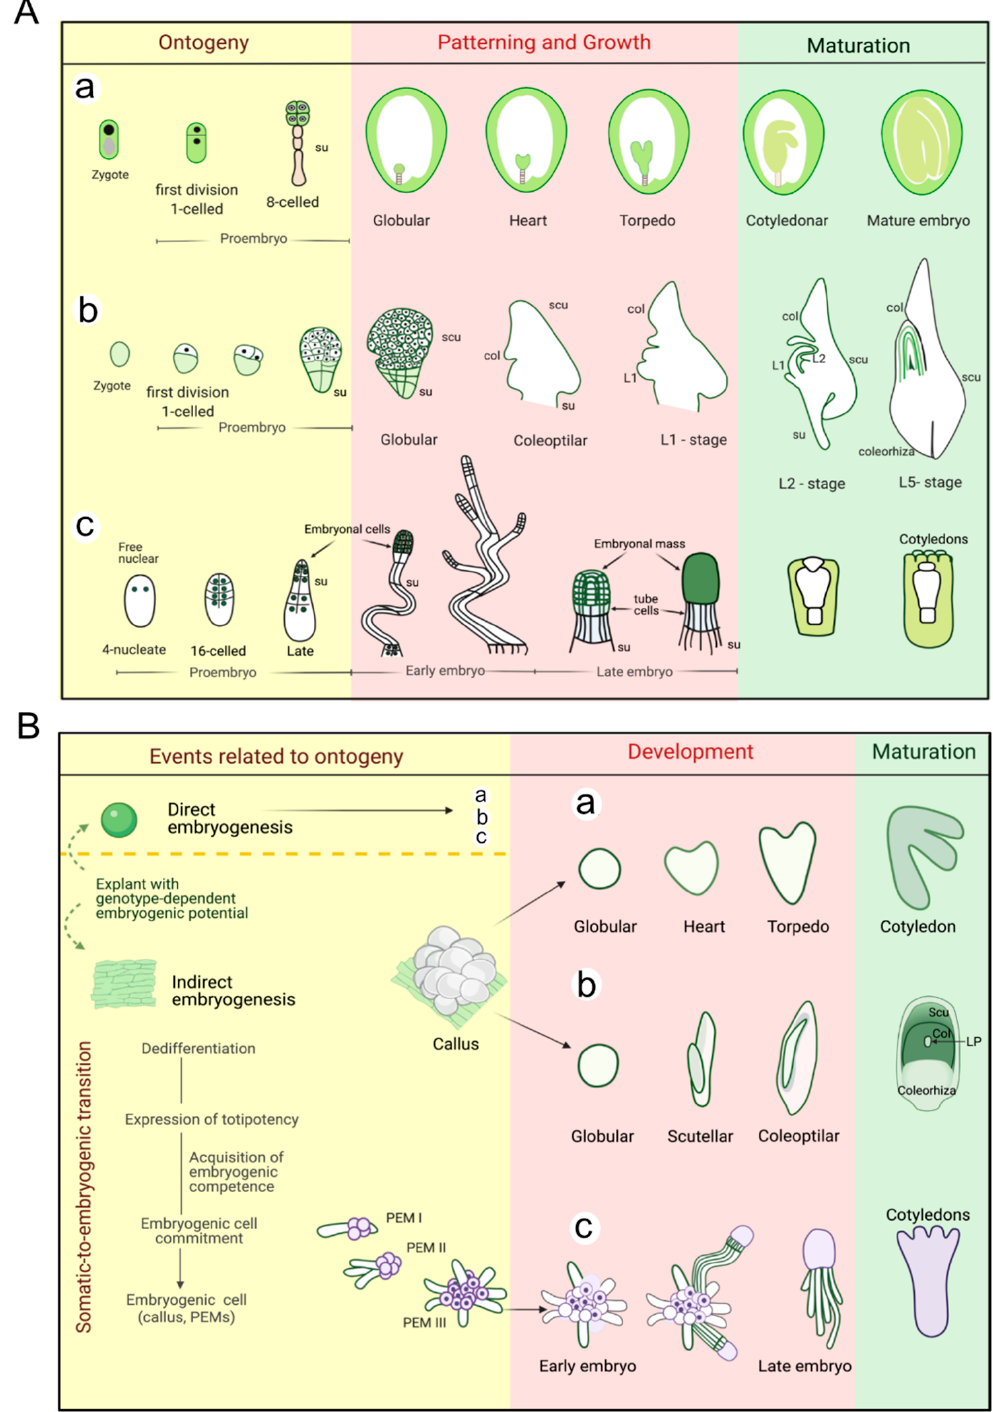
Figure 1. Visual representation of plant embryogenesis. Schematic representation of stereotypical morphological stages of zygotic embryo development in angiosperms and gymnosperms ( A ) Dicots of the Onagrad ( Brassicaceae) type in Arabidopsis thaliana ( a ); monocots based on maize ( Poaceae , ( b ) and gymnosperms (conifers, ( c )). Embryo structures are not drawn to scale. Cells with dark nuclei at early stages contribute to the embryo, while cells without drawn nuclei contribute to the suspensor. Proembryo formation in dicots comprises polarity specification and formation of the suspensor and embryo proper; in monocots the suspensor region arises from irregular cell divisions of the three-celled structure; and in gymnosperms, it comprises the divisions before the suspensor elongation. Embryo development involves embryonic